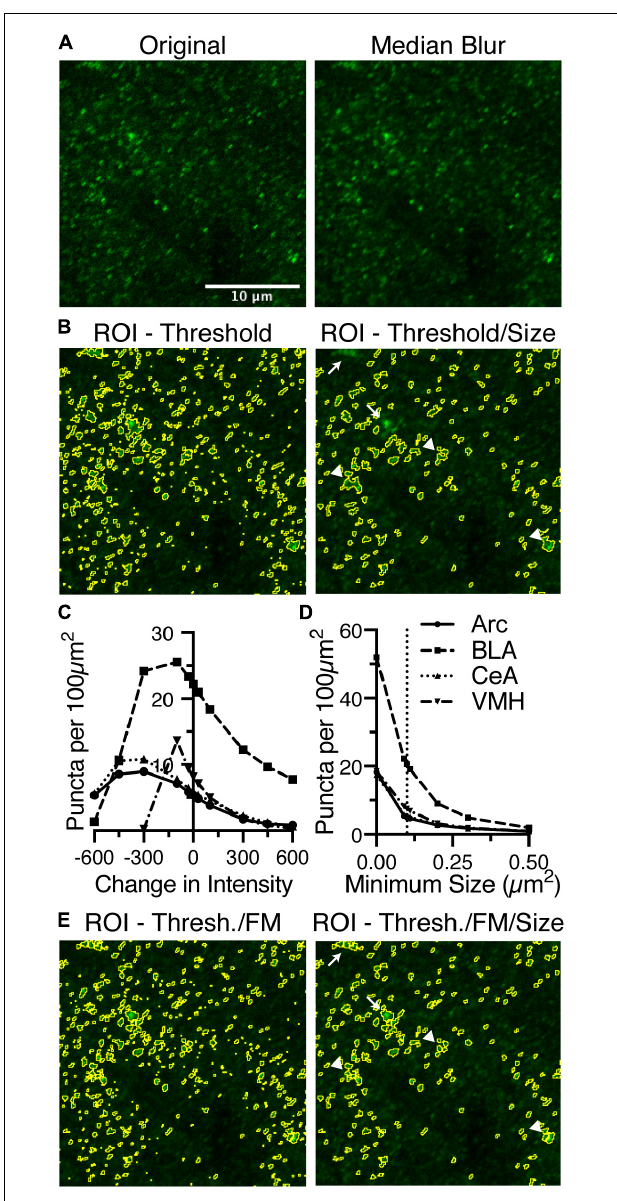
FIGURE 3 | Identification of puncta in sparsely labeled images are dictated by an intensity threshold and minimum size and may still be enhanced by using the same process as densely labeled images. (A) Anti-gephyrin staining in BLA is one such marker that is sparsely labeled. The original image is median blurred to smooth noise. (B) The ROIs, circled in yellow, selected based upon a threshold intensity are further refined by removing puncta that are too small or big. (C) Gephyrin puncta was examined in four brain regions (Arc, dot continuous line; BLA, squares and dashed line; CeA, triangles and dotted line; VMH, inverted triangle and dash-dot line) Puncta number are negatively correlated with changes in threshold intensity, until the threshold has been reduced too far. (D) Puncta number is also negatively correlated with changes in minimum size. (E) Reanalysis of anti-gephyrin staining in BLA using the dense analysis method identified different puncta. Puncta denoted by arrows are absent from the final image in panel (B) while present in the final image in panel (E) . Puncta denoted by arrowheads are present in image panel (B) , but have been sub-divided in panel (E) . Scale bar denoted in panel (A) is 10 µ m for all